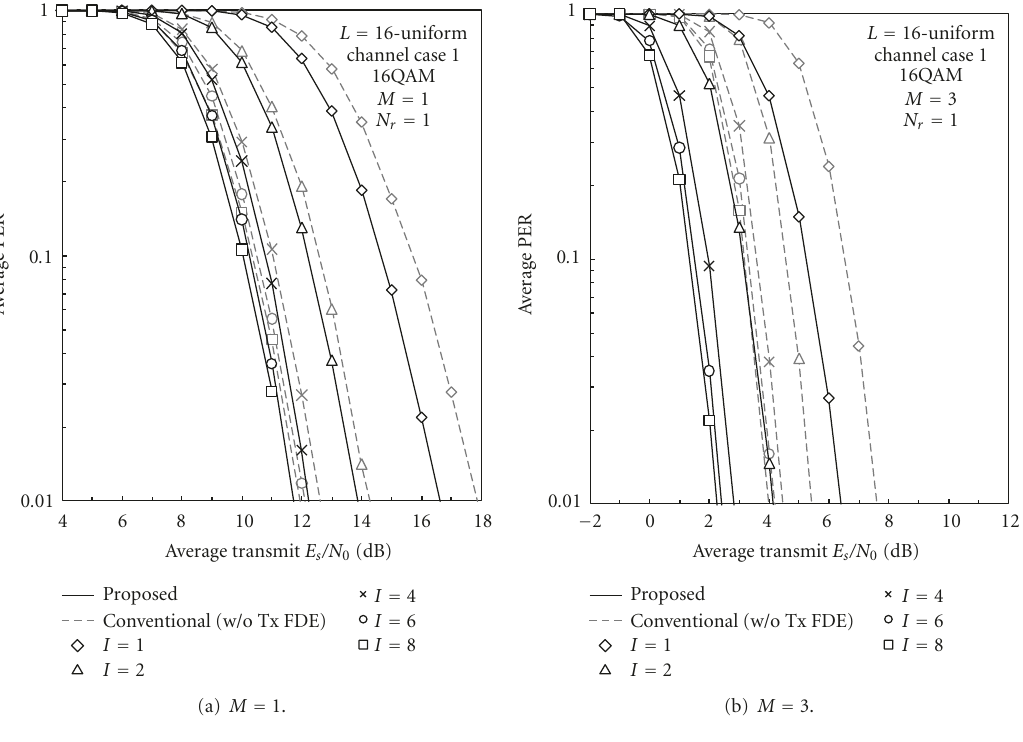
Figure 5: Average PER performance.